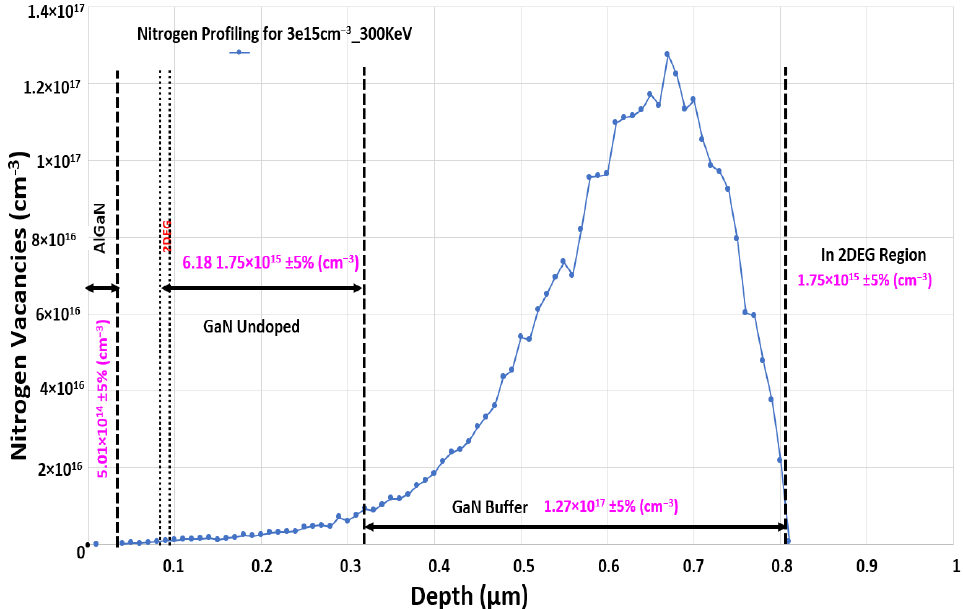
Figure 2. Nitrogen Implantation profile for AlGaN/GaN